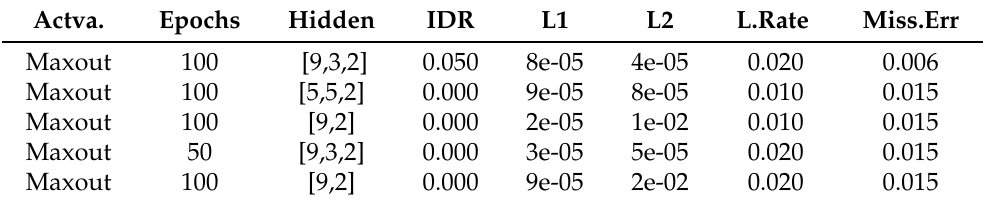
Table 5. Selecting the optimal model for FFNN using misclassification error for the breast cancer data.